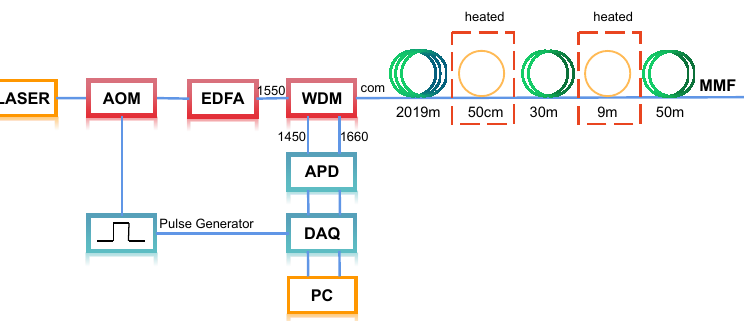
Figure 4. Experimental setup of ROTDR system. AOM, acoustic-optic modulator; EDFA, erbium- doped fiber amplifier; WDM, wavelength division multiplexer; MMF, multimode optical fiber; APD, avalanche photodiode; DAQ, data acquisition card; PC, personal computer.